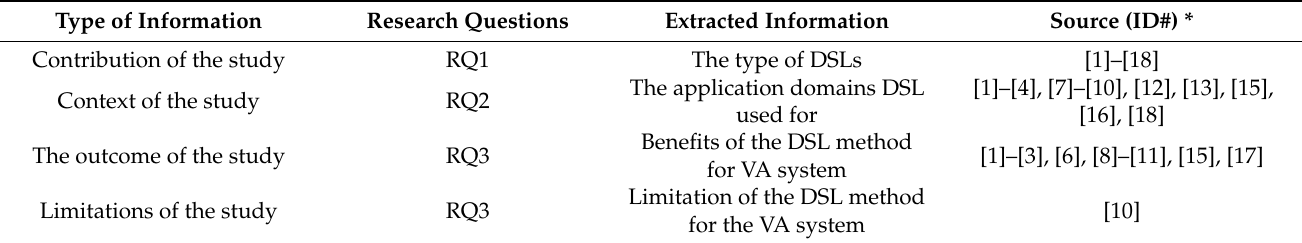
Figure 2. Research Process. Table 1. Types of information extracted based on SLR Methodology.